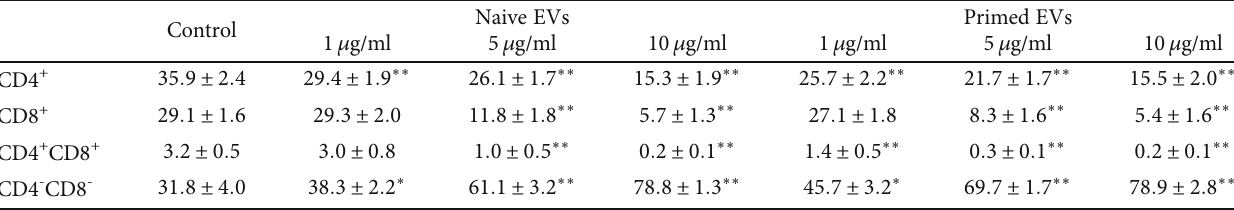
Data are shown as the mean ± S : D . The ratio of T cell subset was not signi fi cantly di ff erent between naive and primed EVs at the same concentrations. ∗∗ P < 0 : 01 vs. control (PBMCs that were not cocultured with cADSC-EVs). ∗ P < 0 : 05 vs.